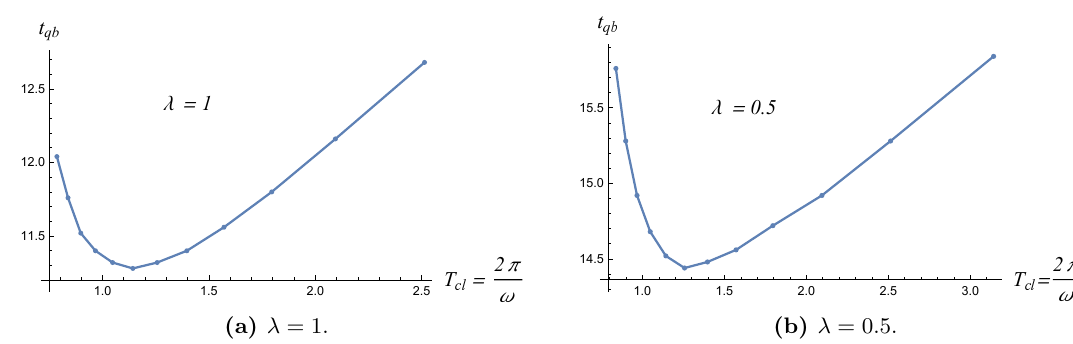
Figure 3 . Quantum break-time as a function of period of initial classical